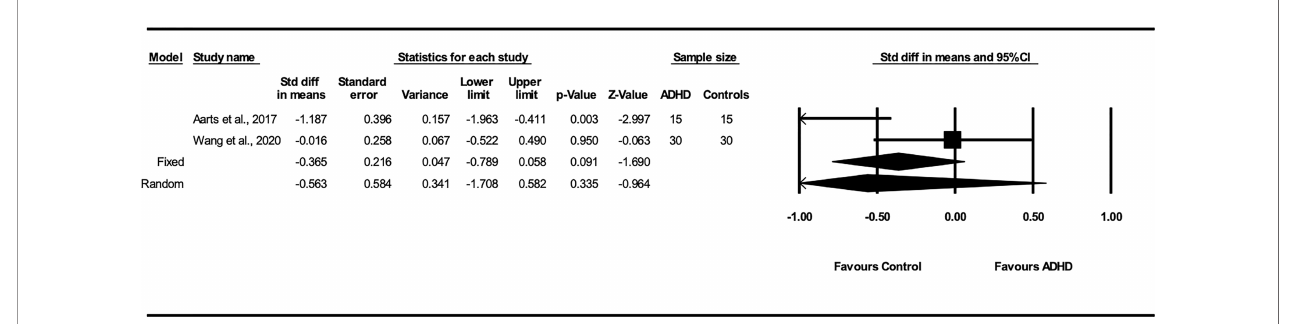
FIGURE 6 | Forest plot of the pooled effect sizes in the standardized difference in means for the Firmicutes in the fecal samples of children with and without ADHD across all studies. Firmicutes may be lower in children with ADHD compared to healthy controls without ADHD ( p =.091). ADHD , Attention-De fi cit/Hyperactivity Disorder; CI , con fi